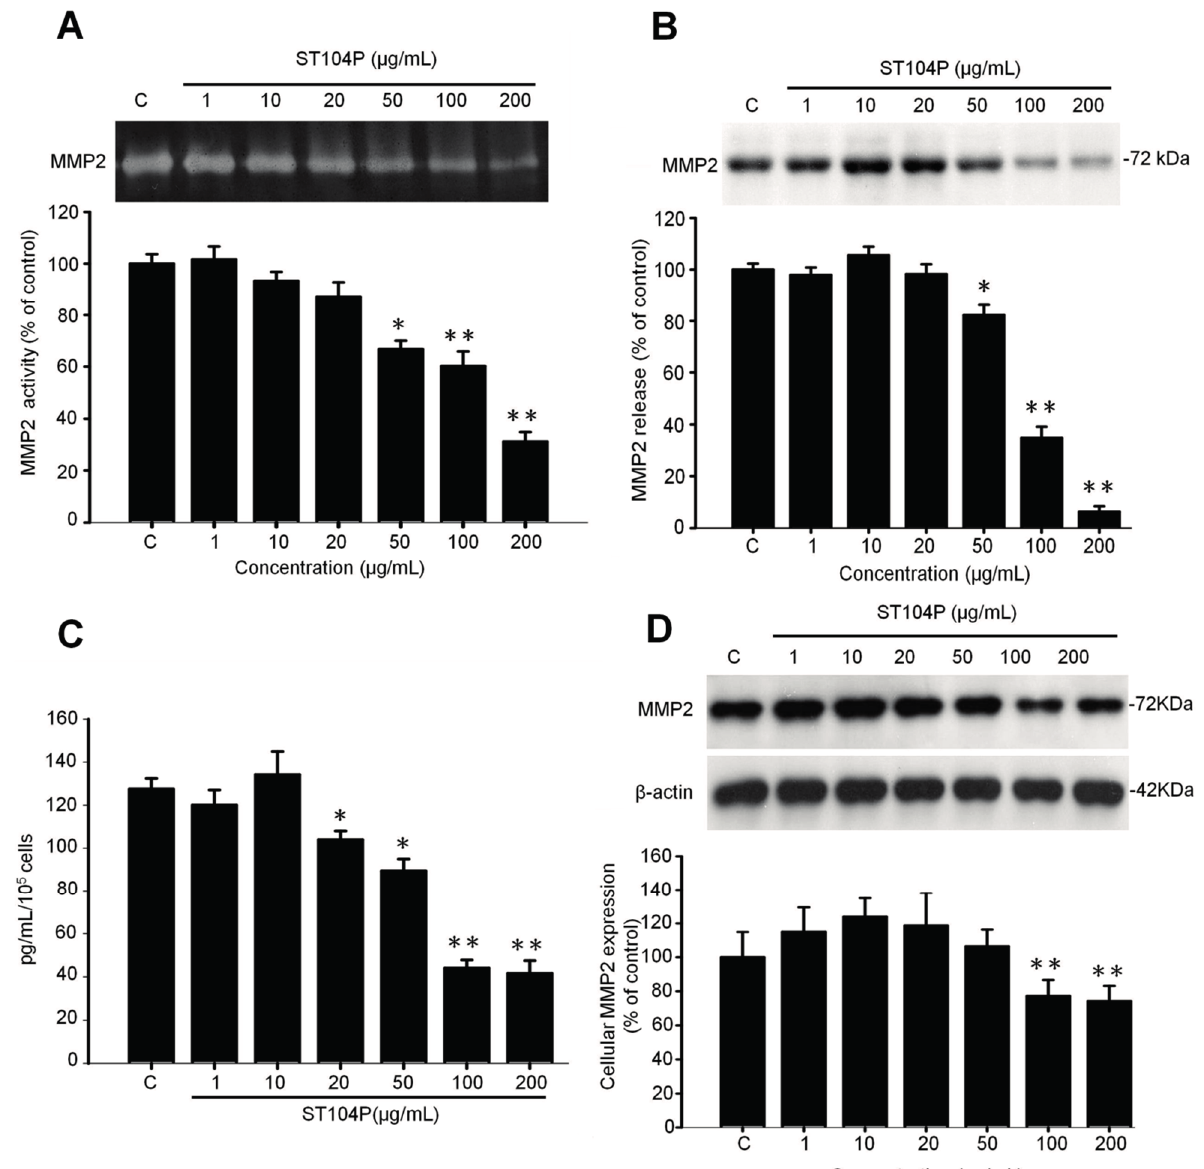
Figure 5. Effect of ST104P on matrix metalloproteinases (MMPs) expression in endothelial cells. HUVEC were treated with various concentration of ST104P (1–200 μ g/mL) for 24 h, the condition media and pellet were collected and performed to determine the MMPs expression in HUVECs. ( A ) MMP-2 activities were analyzed by gelatin zymography, gelatinolytic activities of MMP-2 (72 kDa) were indicated by clear bands in the zymograms with viability cell amount serving as a loading control. To evaluate MMP-2 secretion from HUVECs in culture medium, MMP-2 expression was tested by Western blot ( B ) and ELISA analysis ( C ), after normalization based on viability cell proteins; and ( D ) The expression of cytosolic MMP-2 was determined by Western blot and normalized with β -actin level. Data were mean ± SEM of triplicates. Asterisks indicate statistical significance versus control. * p ˂ 0.05 and ** p ˂